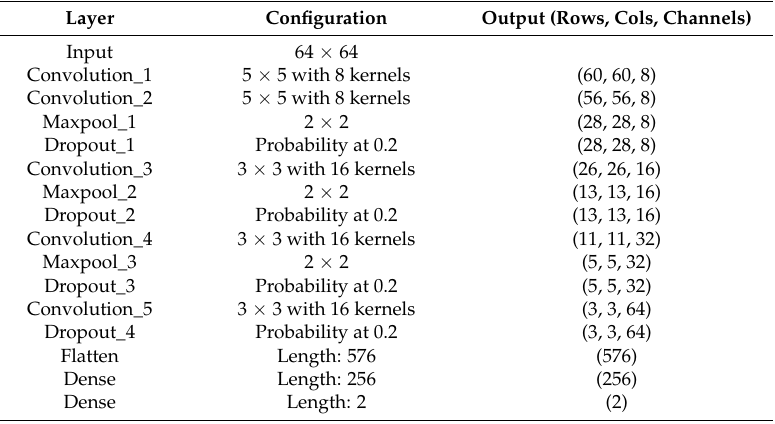
Table 1. Layer breakdown for the proposed CGFace